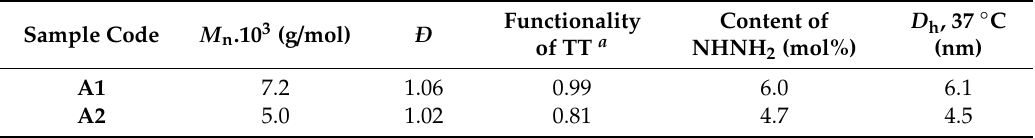
Table 1. Characterization of semitelechelic hydrophilic block A1 and